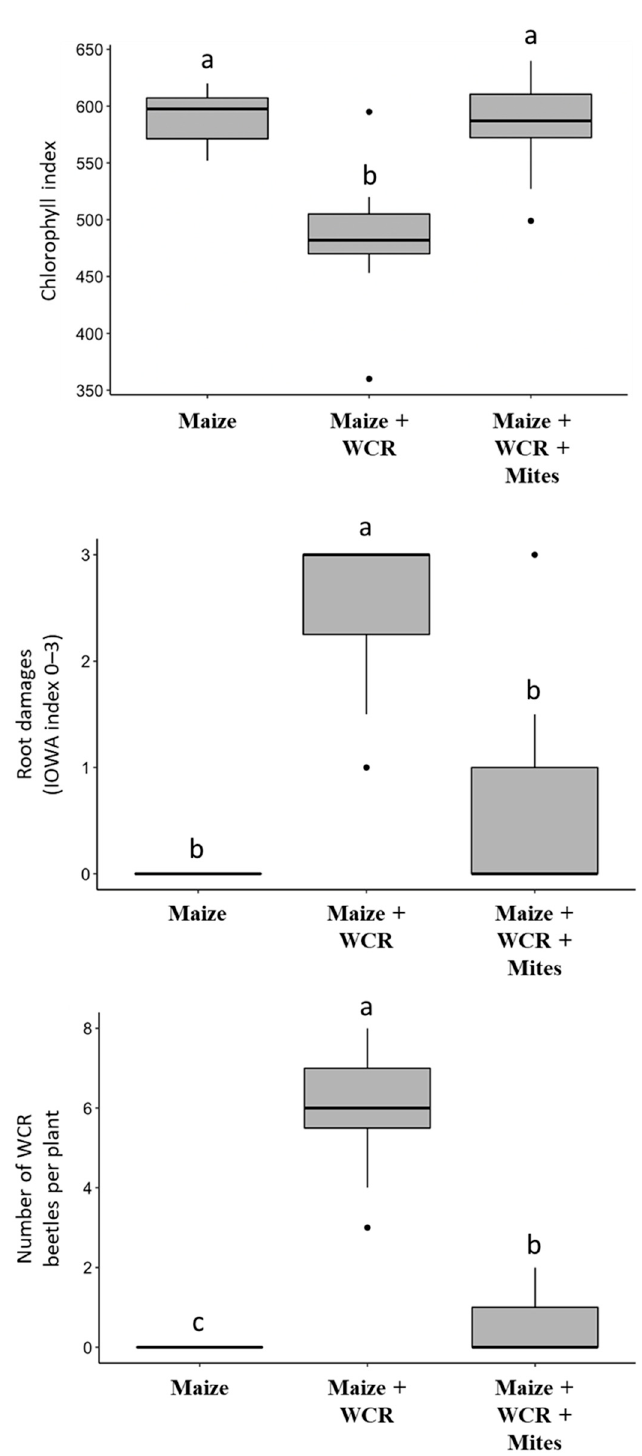
Figure 1. Greenhouse trial. Impact of the maize treatments (maize vs. maize + WRC vs. maize + WCR + mites) on the chlorophyll index (N-tester; top panel), the root-damage index (IOWA index: 0–3; middle panel) and the total number of adults emerging. Boxplot topped by the same letters did not differ significantly.